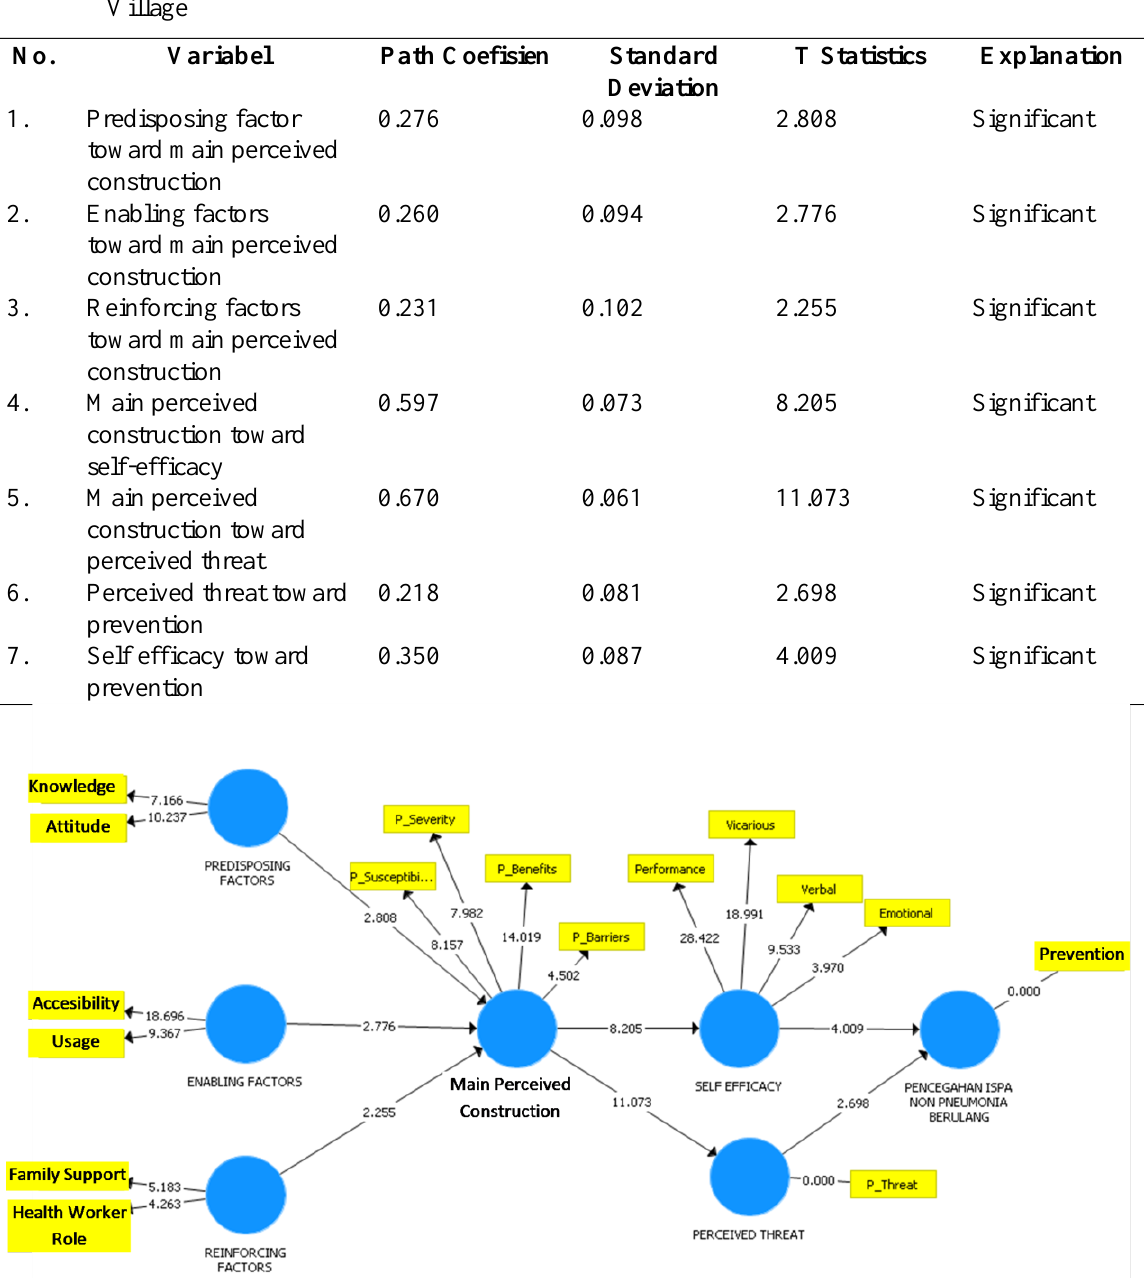
Tabel 3. Hypothesis test results development of model on mothers self-efficacy in preventing recurrence of non-pneumonia acute respiratory infection among toddler in Tanggalrejo